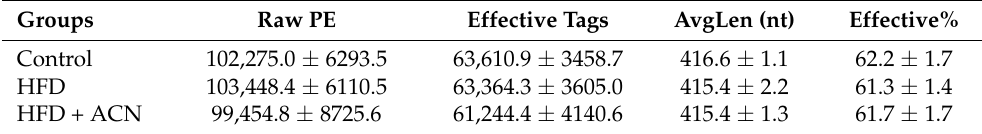
Table 1. Quality control of data. Data were expressed as the mean ± SD, n = 8. Groups